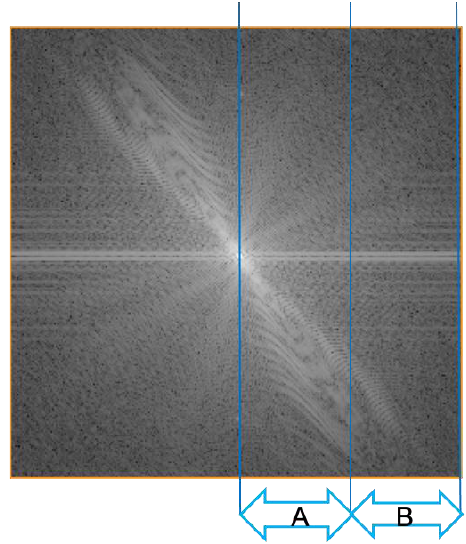
Figure 1. Block diagram presents MR scanner position in the workflow algorithm of radiological decisions made before scanning patients. Notice importance of matrix size setting in the decision process.